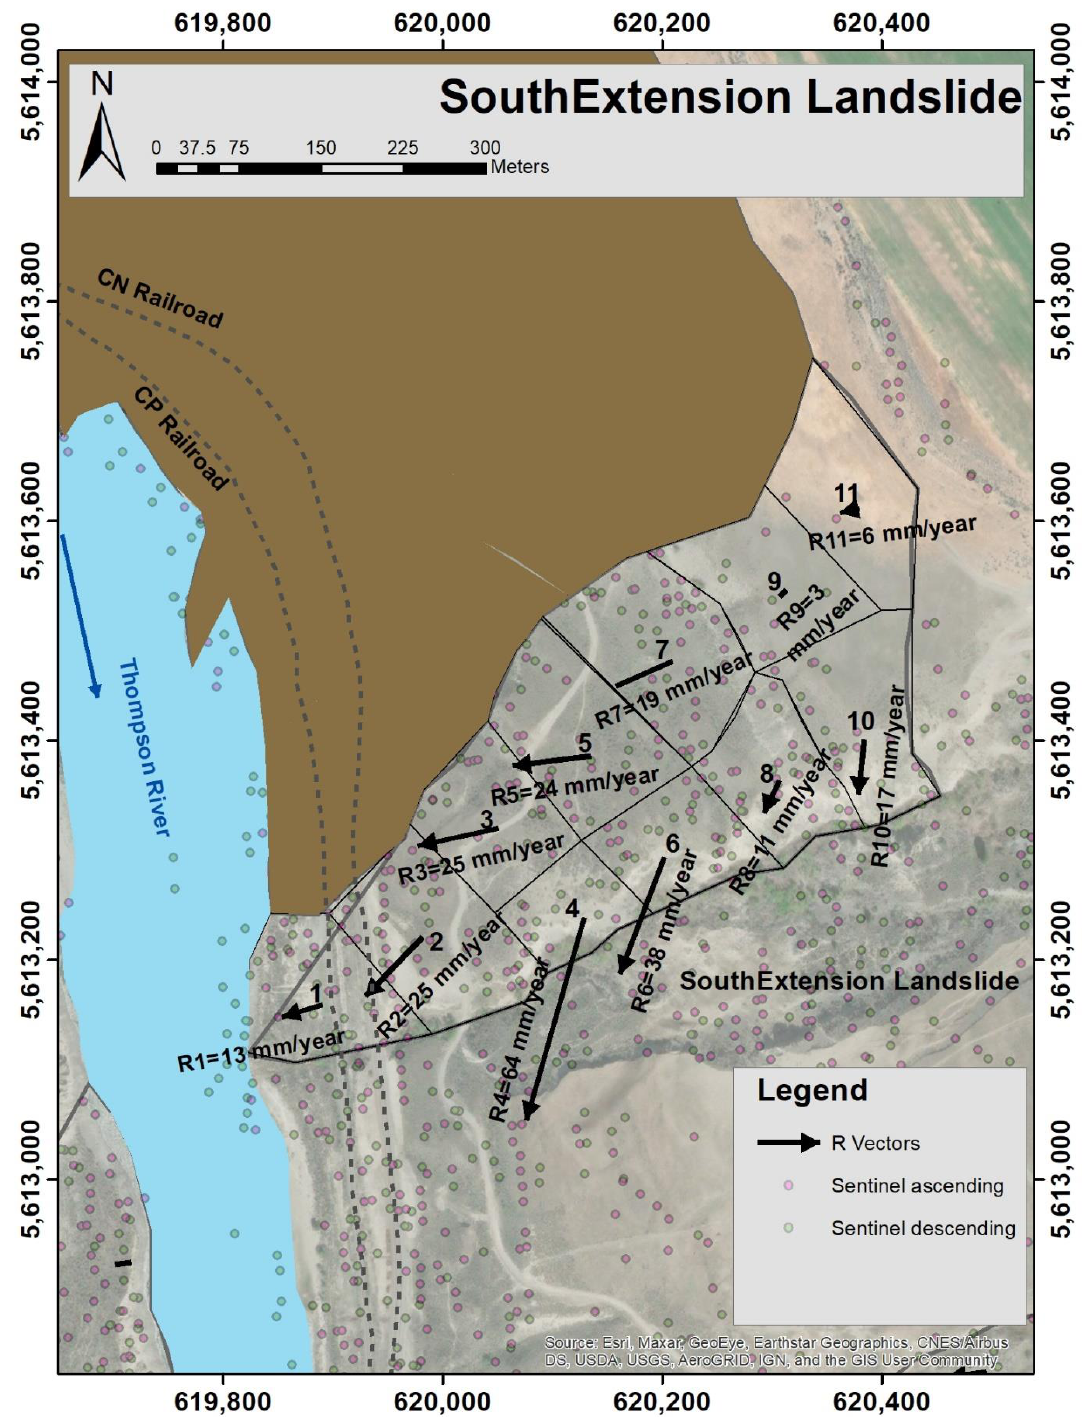
Figure 18. Calculated horizontal component of R within the South Extension landslide. The vertical components of R on the South Extension landslide are shown in Figure 19 for selected sectors of the landslide and selected cross sections. Movement is predominantly horizontal near the toe of the landslide and some sectors upslope and near the back scarp show increased vertical components of movement. Movement is negligible behind the back scarp, suggesting no landslide retrogression beyond that